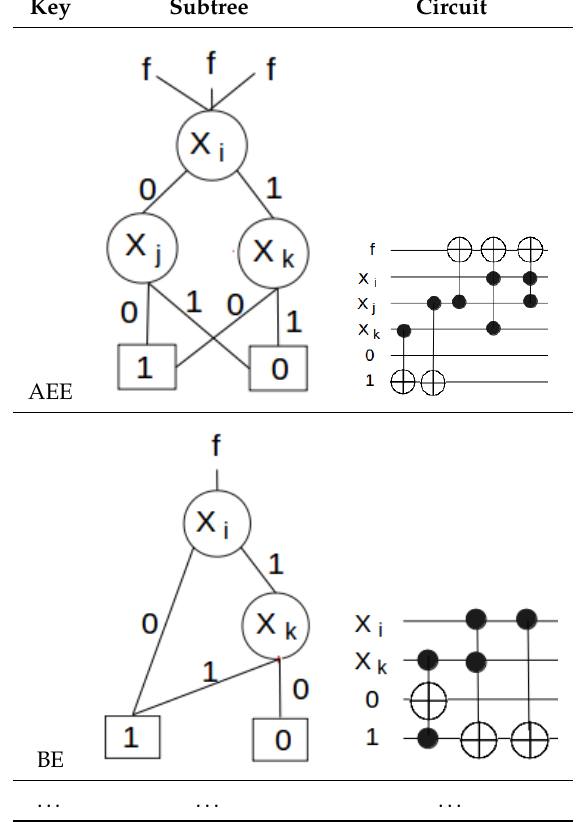
Table 3. Sample subtrees with their mapped reversible gates and assigned hash codes.